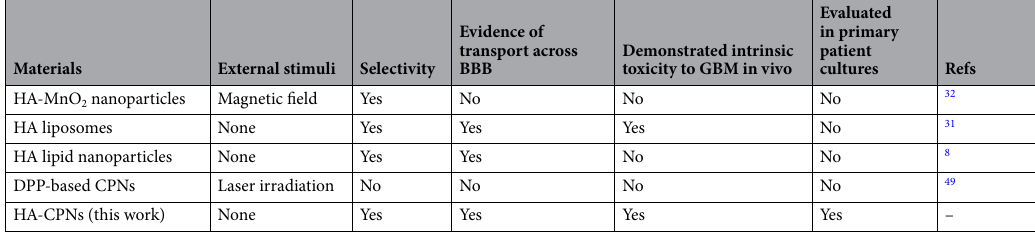
Table 1. Comparison of the new HA-CPNs with selected previously reported nanomaterials against